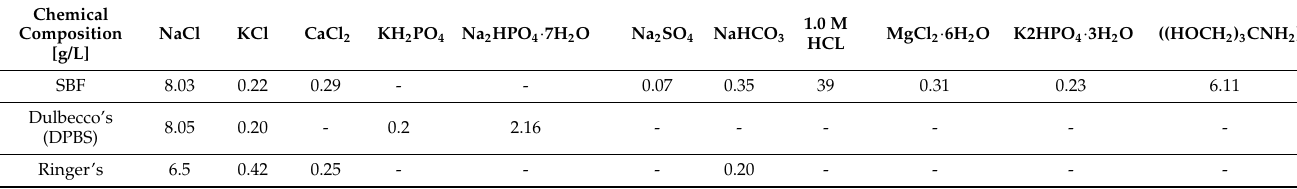
Table 1. Chemical composition of the immersion medium